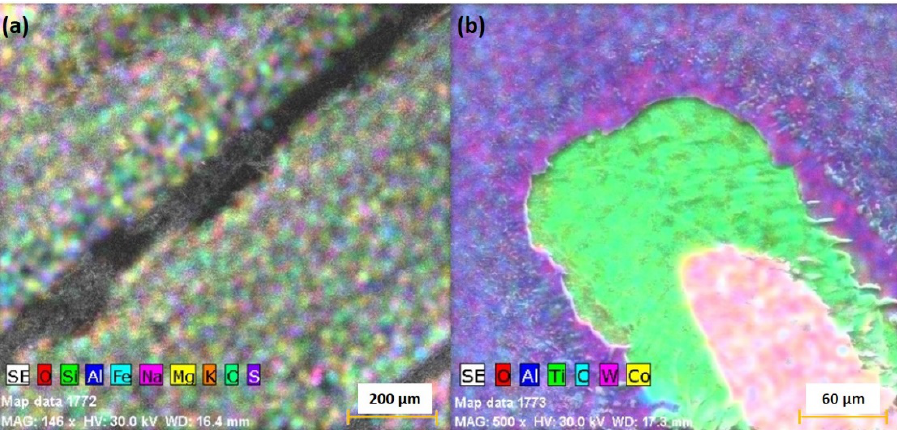
Figure 7. EDX mapping of the post-ablation crater of the C1 ( a ) and C2 ( b ) targets.